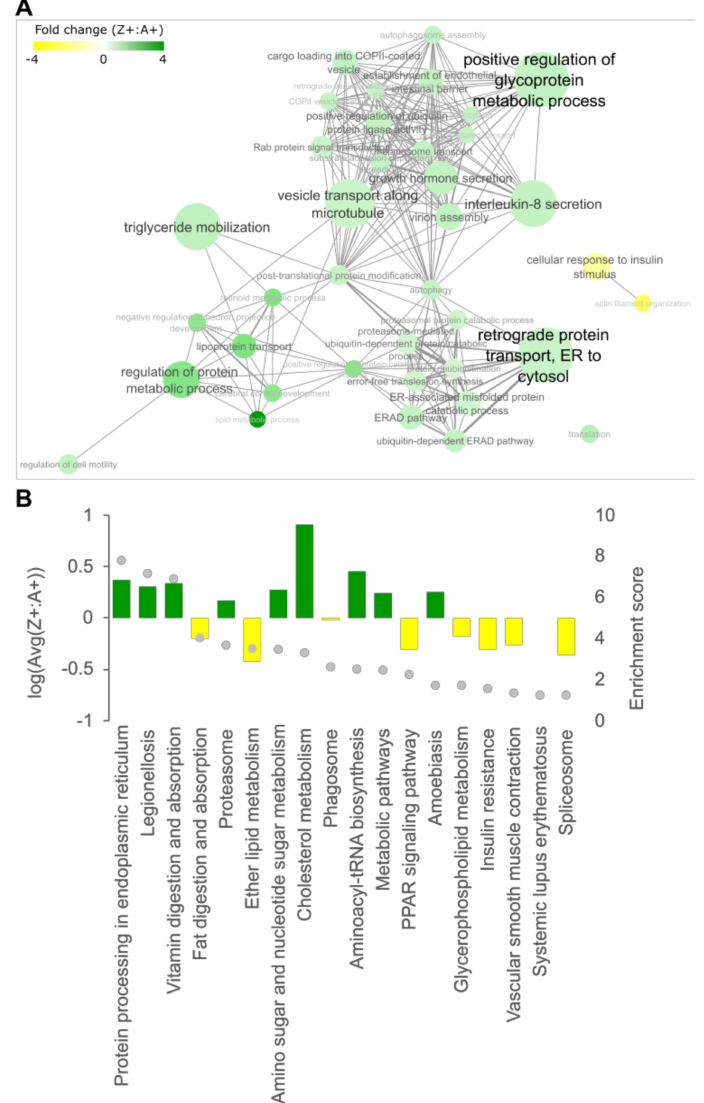
Figure 3. Pathway enrichment analysis of DEPs identified from LC-MS/MS data. Differentially expressed proteins (DEPs) from LC-MS/MS data were mapped to the corresponding human orthologs and ( A ) Gene Ontology (GO) enrichment analysis was performed. The enriched GO annotations under the ‘Biological Process’ category were filtered for annotations containing DEPs that are either all up- or down-regulated. Filtered annotations were then mapped onto an interaction network as nodes and were connected by an edge if there are common DEPs present between nodes. The thickness of the edge correlates to the number of common DEPs shared between two nodes. The size of each node represents the enrichment score from the GO enrichment analysis. Green indicates the up-regulation of the GO term while yellow indicates downregulation. ( B ) KEGG enrichment analysis of DEPs. The histogram shows the direction and average level of dysregulation for all DEPs mapped to each KEGG pathway (left y -axis), and the grey dots indicate enrichment levels (right y